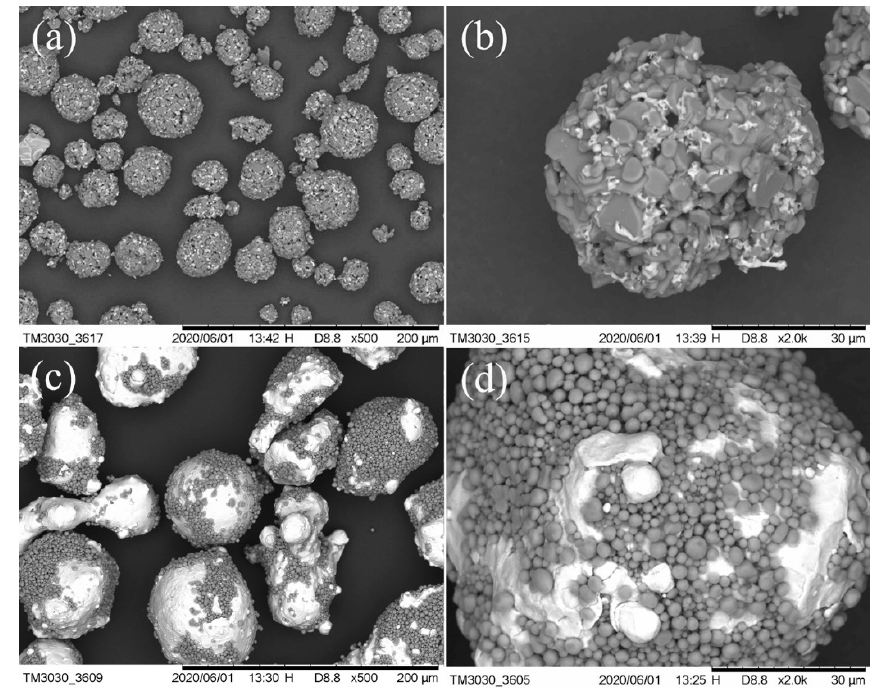
Figure 1. ( a ) As-received A1 2 O 3 -13 wt.% TiO 2 (AT13) particles at X500, ( b ) as-received AT13 particles at X2000, ( c ) as-received Ni5Al composite particles at X500, and ( d ) as-received Ni5Al composite particles at X2000.